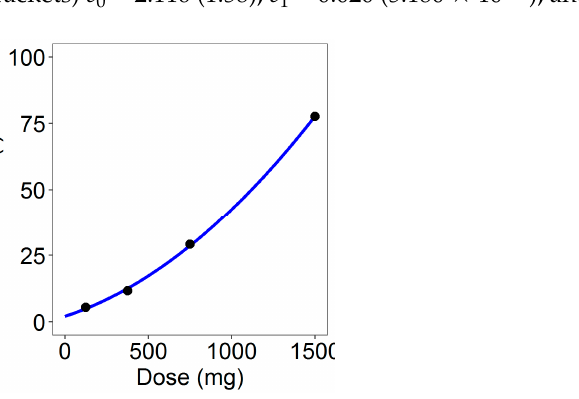
Table 6. Estimates of the γ parameter.